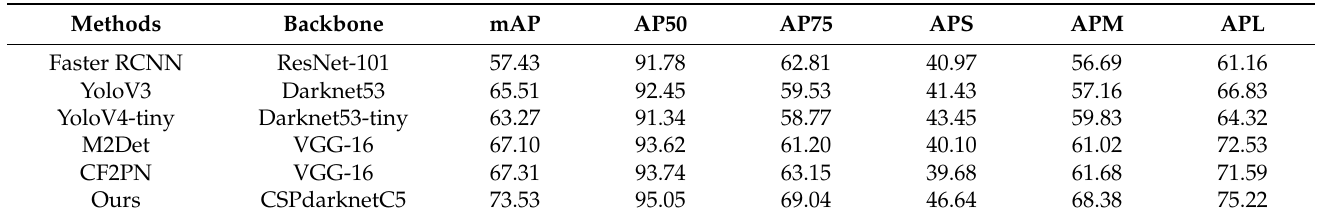
Table 6. Comparison experiments of the AP values for different methods for the NWPU-VHR-10 dataset.